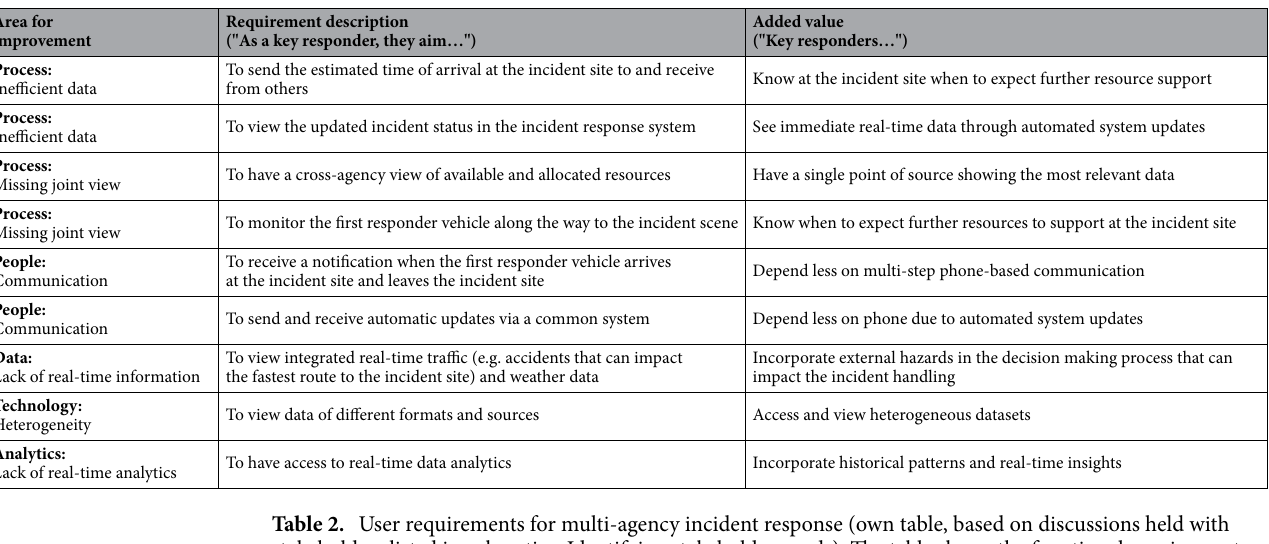
Table 2. User requirements for multi-agency incident response (own table, based on discussions held with stakeholders listed in subsection Identifying stakeholder needs). The table shows the functional requirements for each area of improvement: Processes, People, Data, Technology, and Analytics. In addition, the table shows the benefits and added value of the implemented functionalities for the stakeholders involved in the incident process.